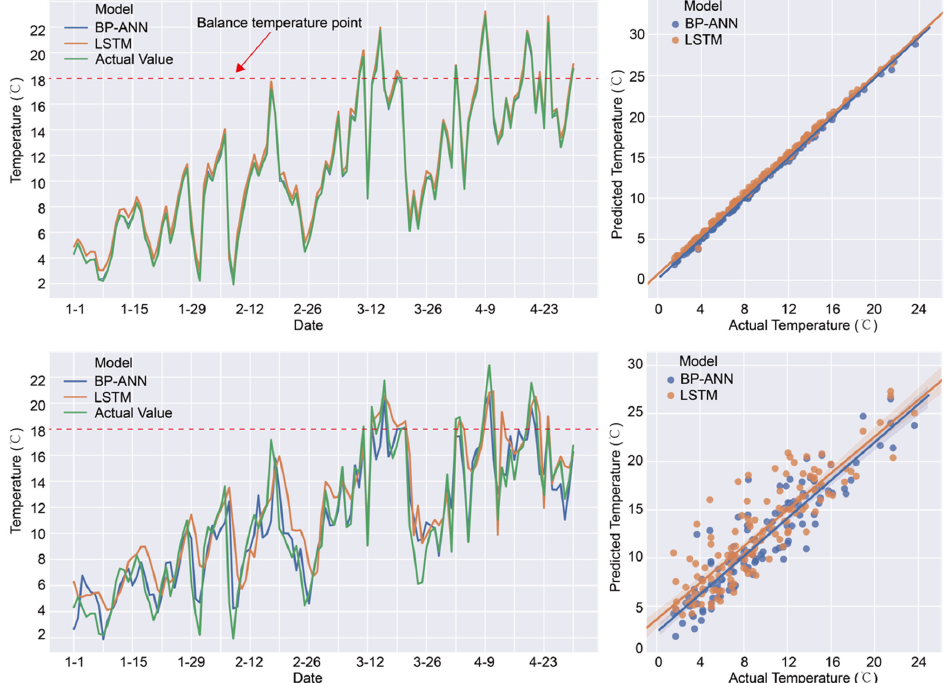
Figure 5. The prediction results of daily average temperature using BP-ANN and LSTM techniques in Model 1 ( up ) and 2 ( below ).